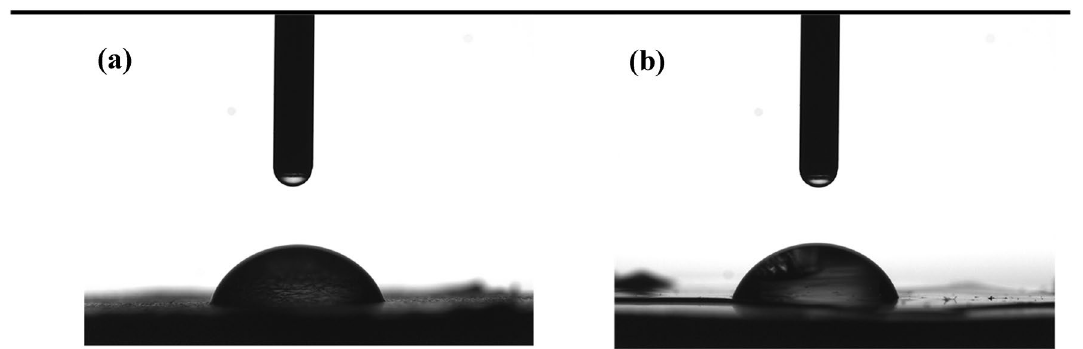
Figure 4. Water contact angle measurements of (a) TON-Gel, (b) TON-Gel-GO.